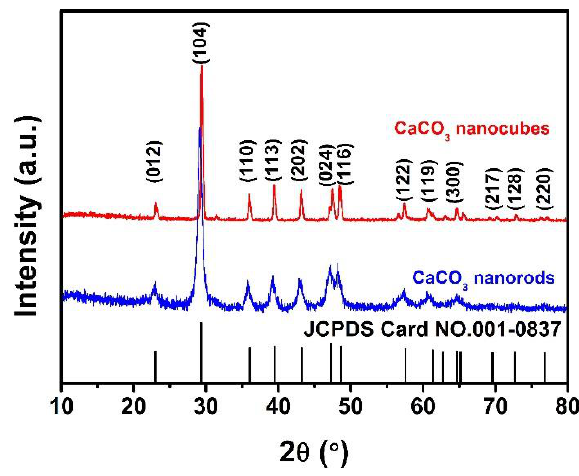
Figure 1. XRD patterns of CaCO 3 nanocubes and CaCO 3 nanorods.